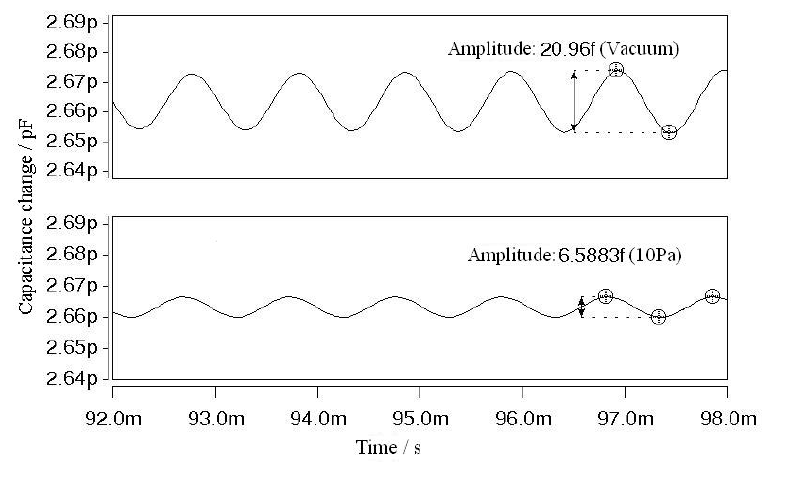
Figure 13. Δ C output in a 10 Pa pressure and vacuum